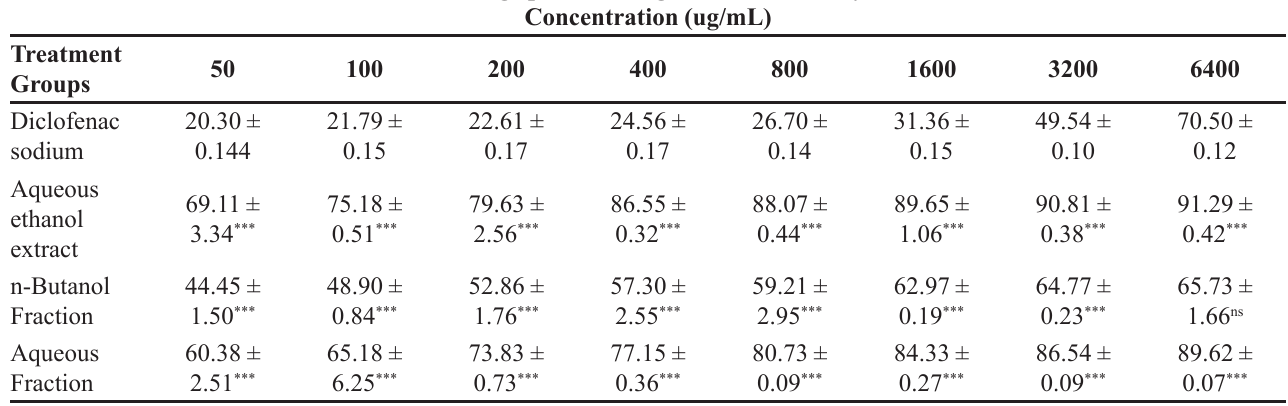
TABLE III - Percent stabilization of Human red blood cell membrane by Ribes alpestre Percentage protection against membrane